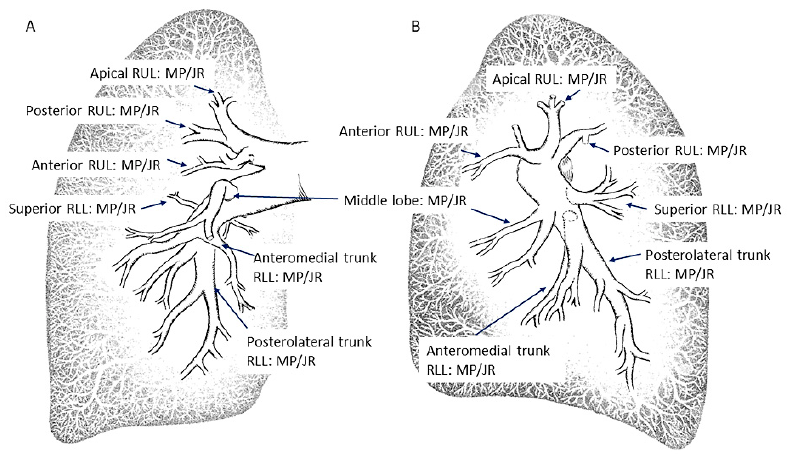
Figure 1. Right lung segmental arteries and catheters to canalize them: ( A ) anteroposterior view and ( B ) lateral view. JR: Judkins right; MP: multipurpose; RUL: right upper lobe; RLL: right lower lobe.